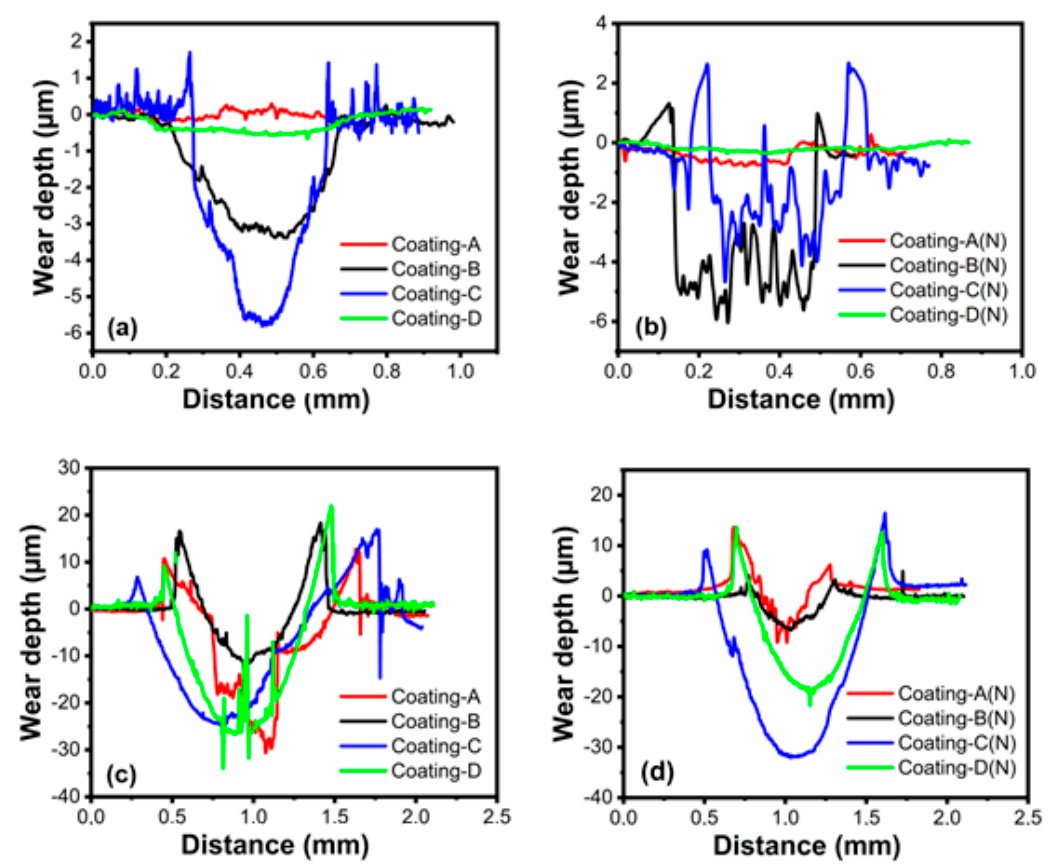
Figure 9. Wear scar profiles of the coatings: ( a ) wear scar depth profiles of the coatings on non- nitrided steel at 20 °C, ( b ) wear depth profiles of the coatings on nitrided steel at 20 °C, ( c ) wear scar depth profiles of the coatings on non-nitrided steel at 700 °C, ( d ) wear scar depth profiles of the coatings on nitrided steel at 700 °C.